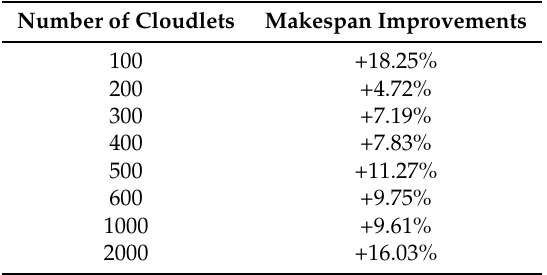
Table 11. Improvements of the MBO-ABC over the original MBO in simulations with a HPC2N data set.